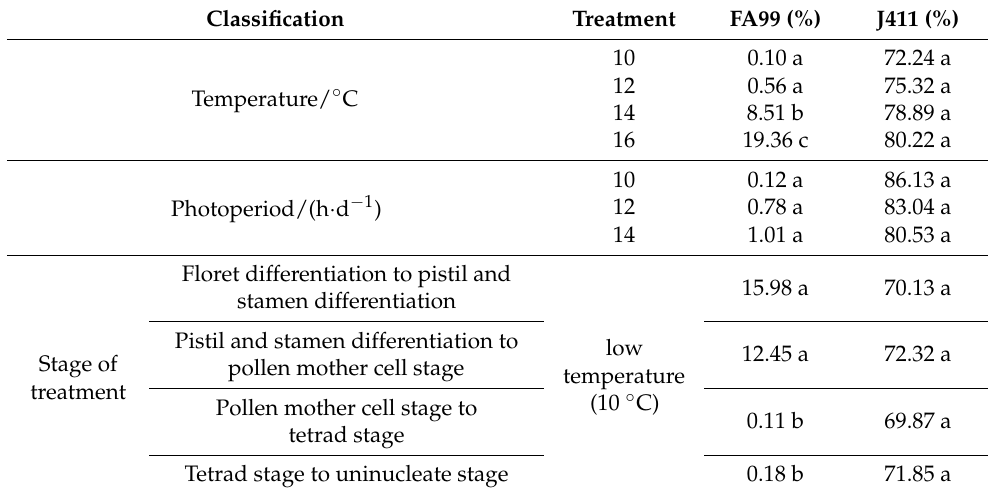
Table 2. Identification of photo-thermo-sensitive and fertility conversion stage.